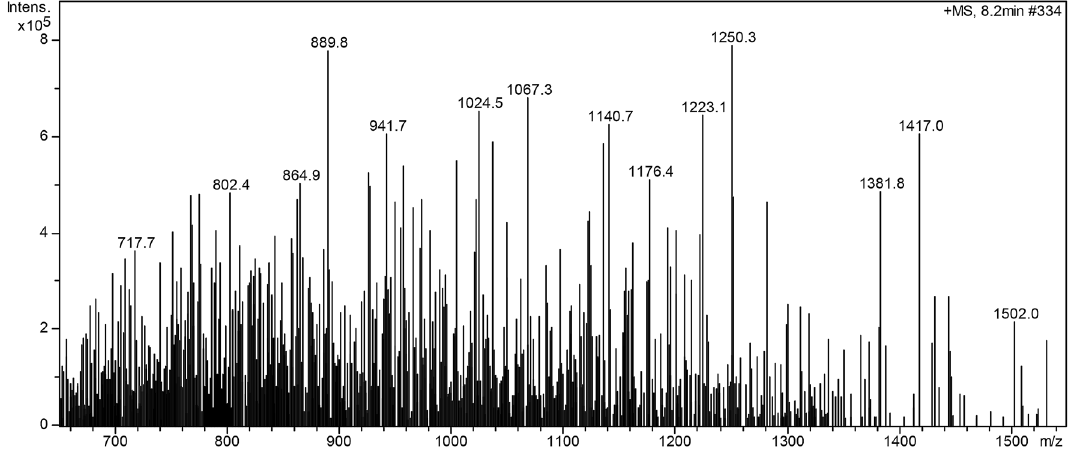
Figure 6. MS figure of the non-silicon oxygen bleaching